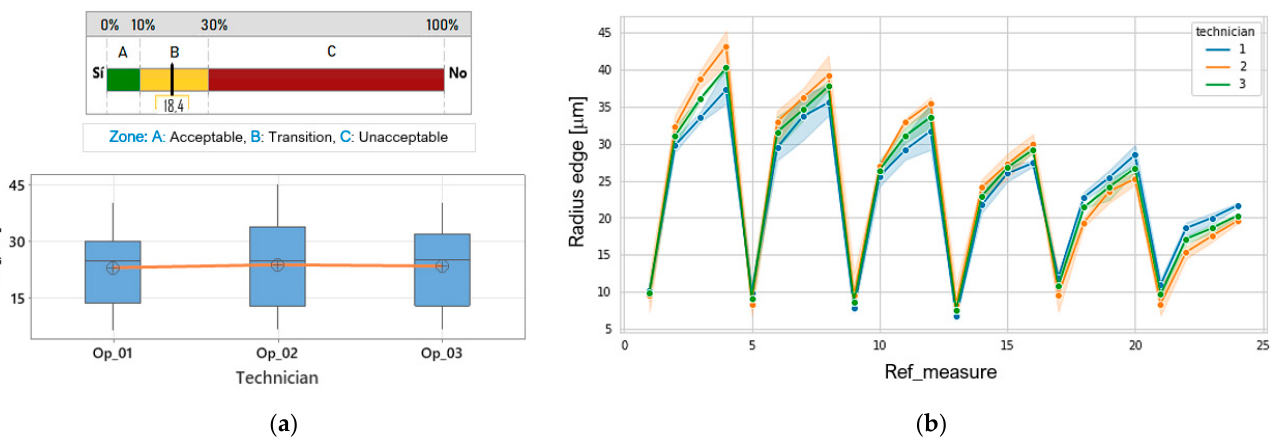
Table 2. Characterization of the honed cutting edge.